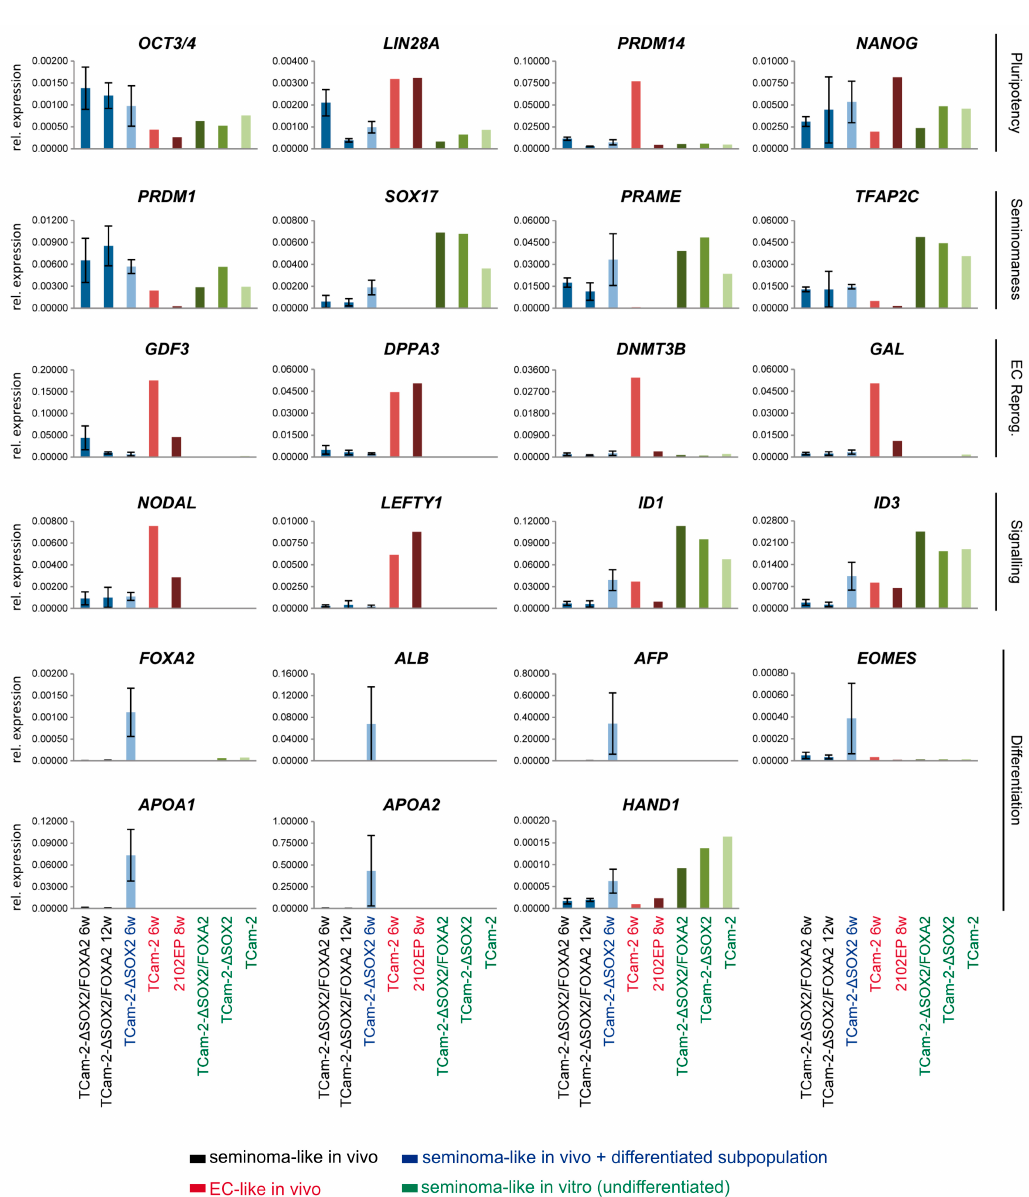
Figure 4. qRT-PCR analysis of indicated marker genes in TCam-2- ∆ SOX2 / FOXA2 (six ( n = 4) and twelve weeks ( n = 5)) and TCam-2- ∆ SOX2 (six weeks ( n = 4)). In vivo reprogrammed TCam-2 (TCam-2 6w) and in vivo grown 2102EP (2102EP 8w) as well as in vitro cultivated TCam-2- ∆ SOX2 / FOXA2 , TCam-2- ∆ SOX2 and parental TCam-2 cells served as controls. Expression levels were normalized against GAPDH .